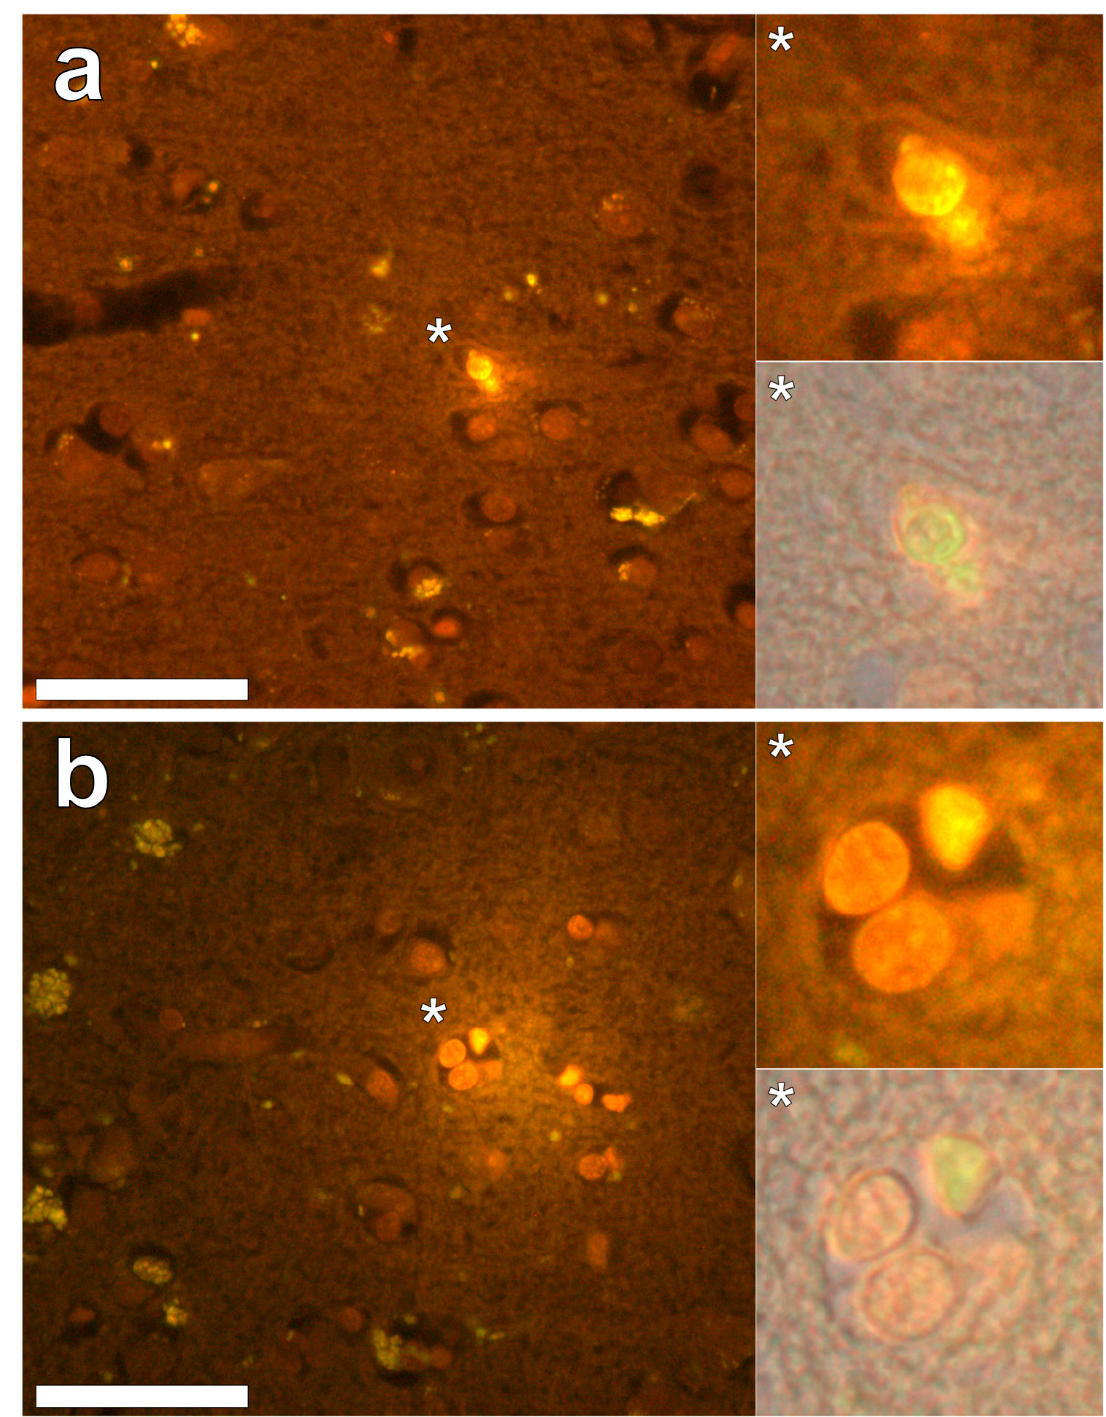
Figure 2. Intracellular aluminium in microglia in close proximity to extracellular deposits of aluminium-rich debris ( a ) and in astrocyte-like cells ( b ) in the occipital cortex. Magnified inserts are depicted (asterisks) with the bright field overlay shown in lower panels. Magnification × 400, scale bars: 50 µm.